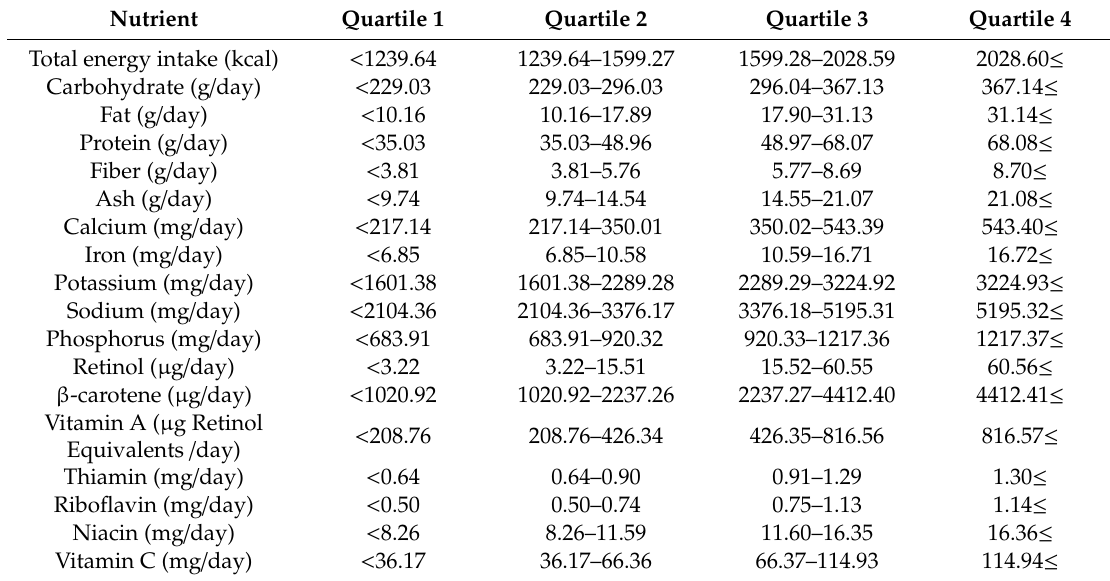
Table 2. Quartile categories of nutrient